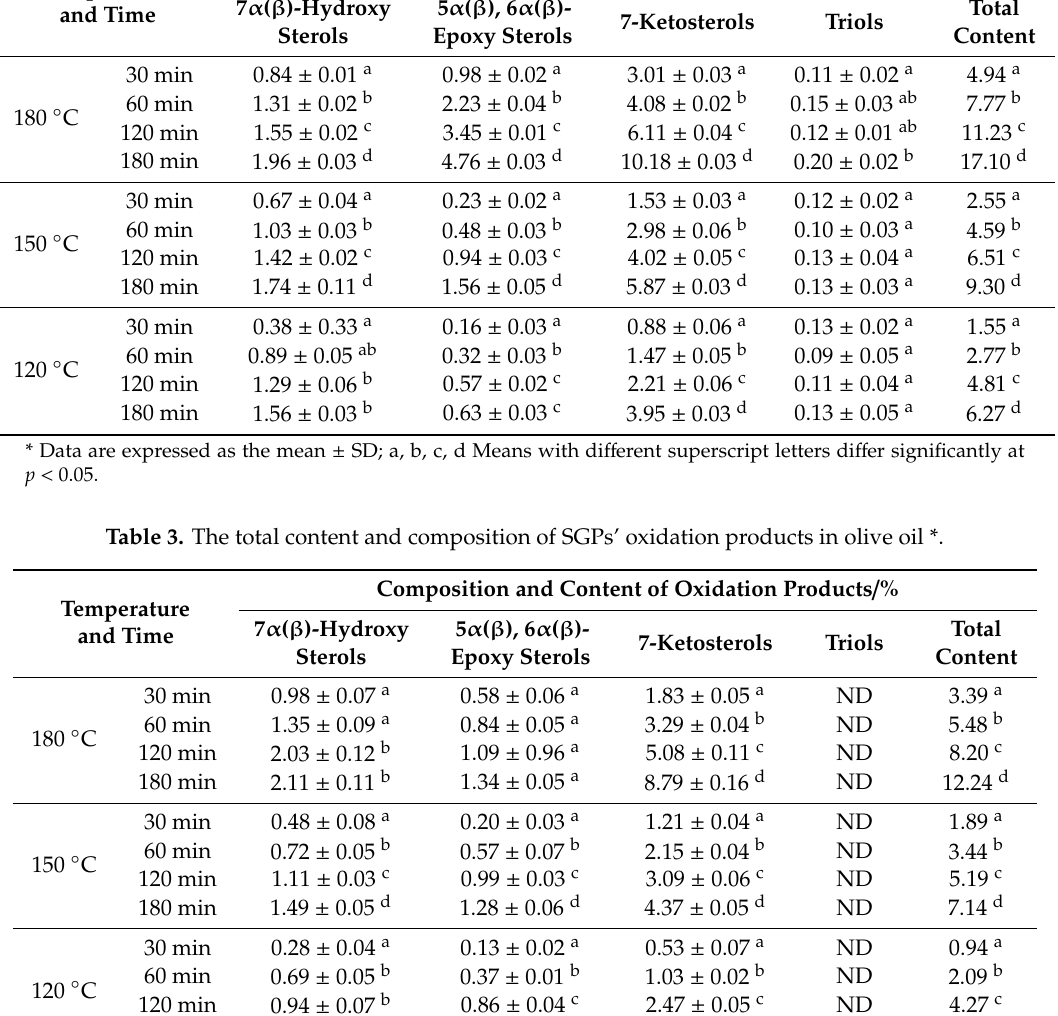
Table 2. The total content and composition of SGPs’ oxidation products in soybean germ oil *. Temperature and Time